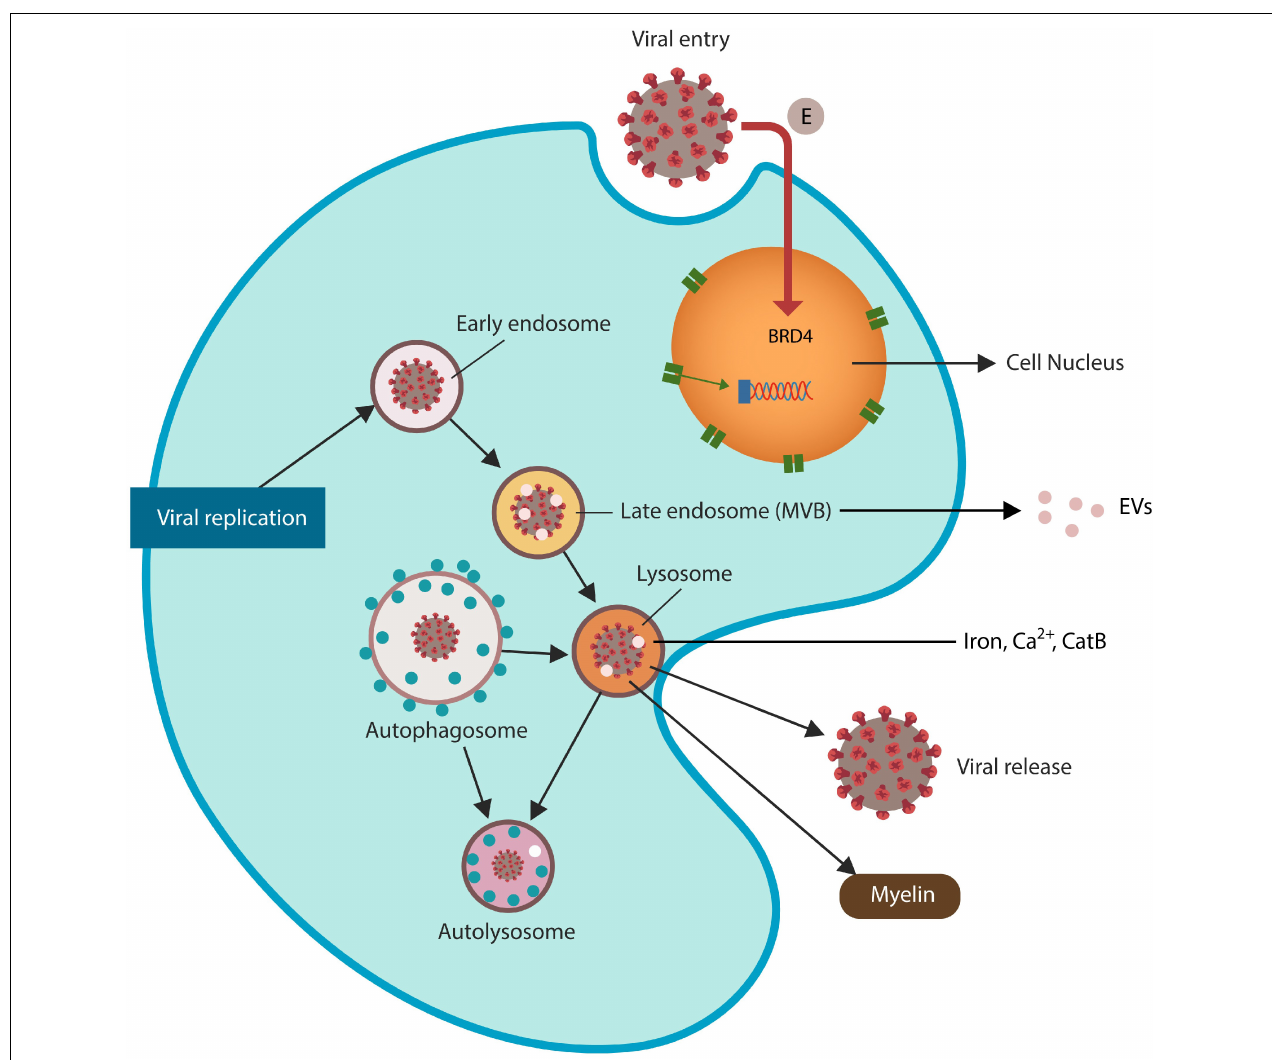
FIGURE 1 | SARS-CoV-2 virus and HIV Tat antigen ingress host cells via ELS. The SARS-CoV-2 envelope (E) protein is a direct inhibitor of BRD4, increasing the risk of ferroptosis. Viruses that exploit ELS to egress host cells may disrupt lysosomal exocytosis of myelin and Tau protein (not shown). Late endosomes generate extracellular vesicles (EVs) that can spread viral proteins to the neighboring cells. Dysfunctional lysosomes may “leak” ferroptosis-driving molecules, including iron, Ca 2 + and CatB, contributing to ferroptosis-induced neurodegeneration